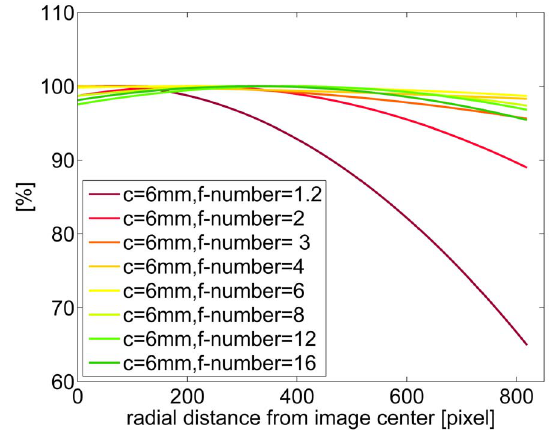
Figure 14: Vignetting of 6 mm lens at f-stops 1,2 -